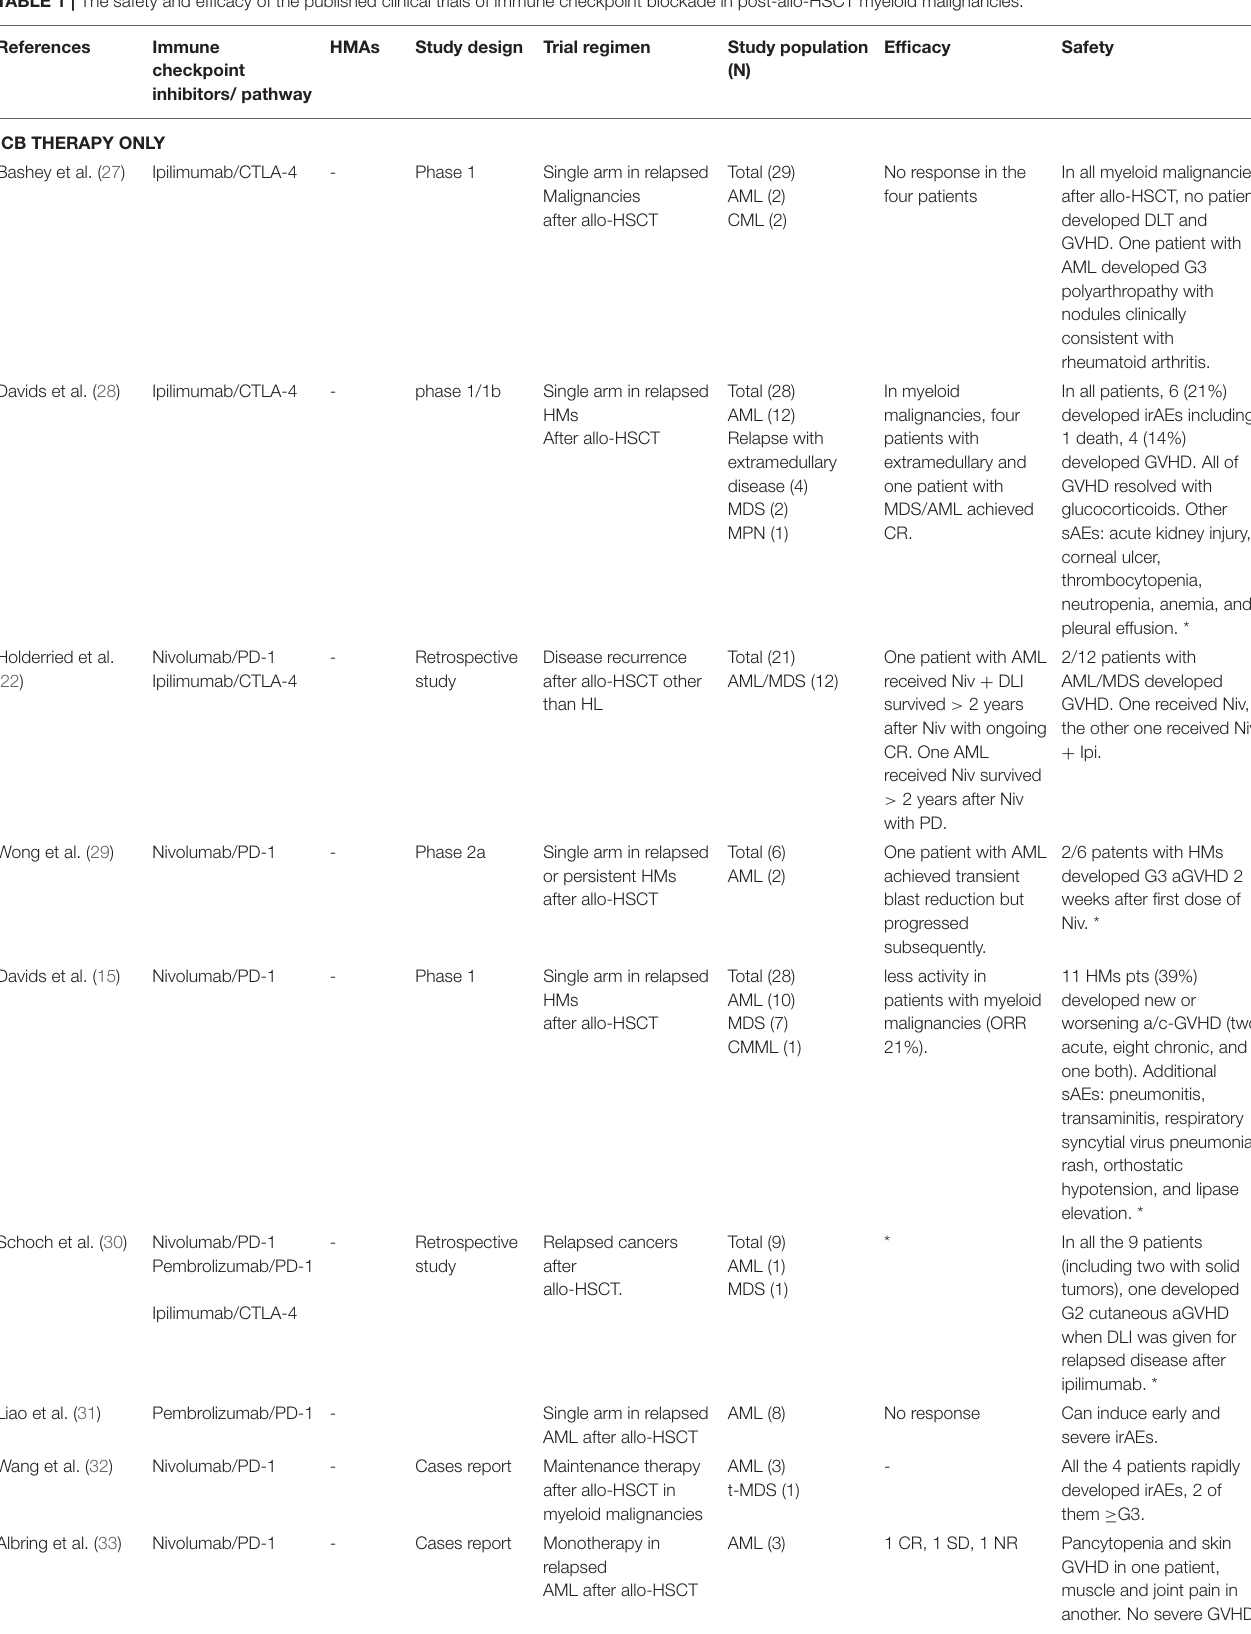
TABLE 1 | The safety and efficacy of the published clinical trials of immune checkpoint blockade in post-allo-HSCT myeloid